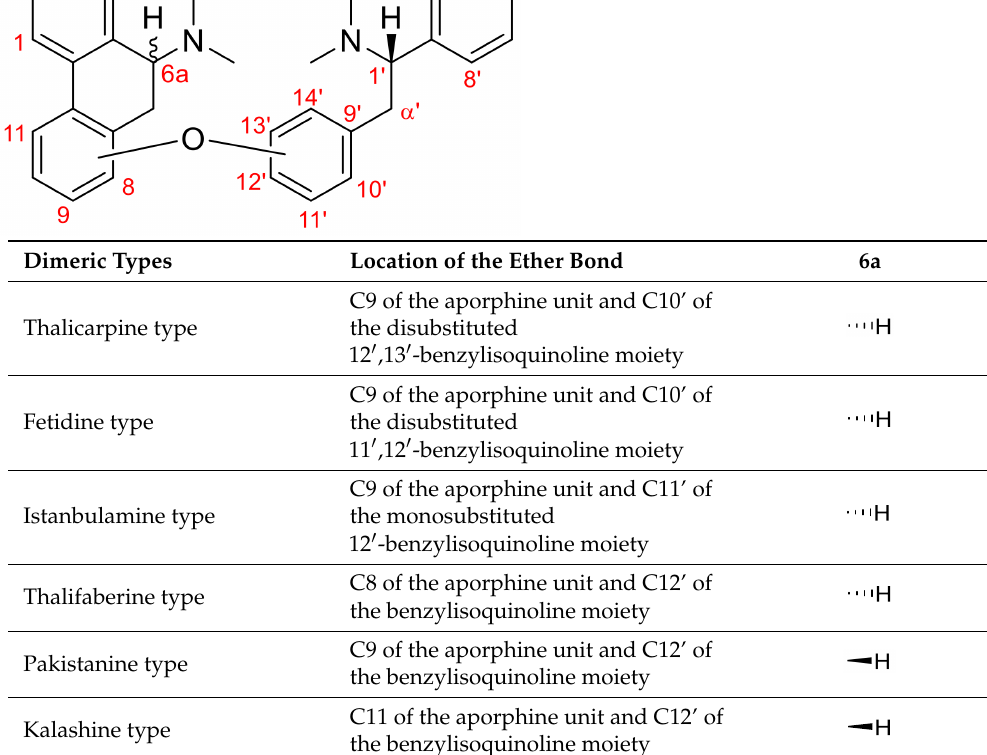
Table 1. Location of the ether bond in different types of aporphine–benzylisoquinoline dimeric alkaloids.